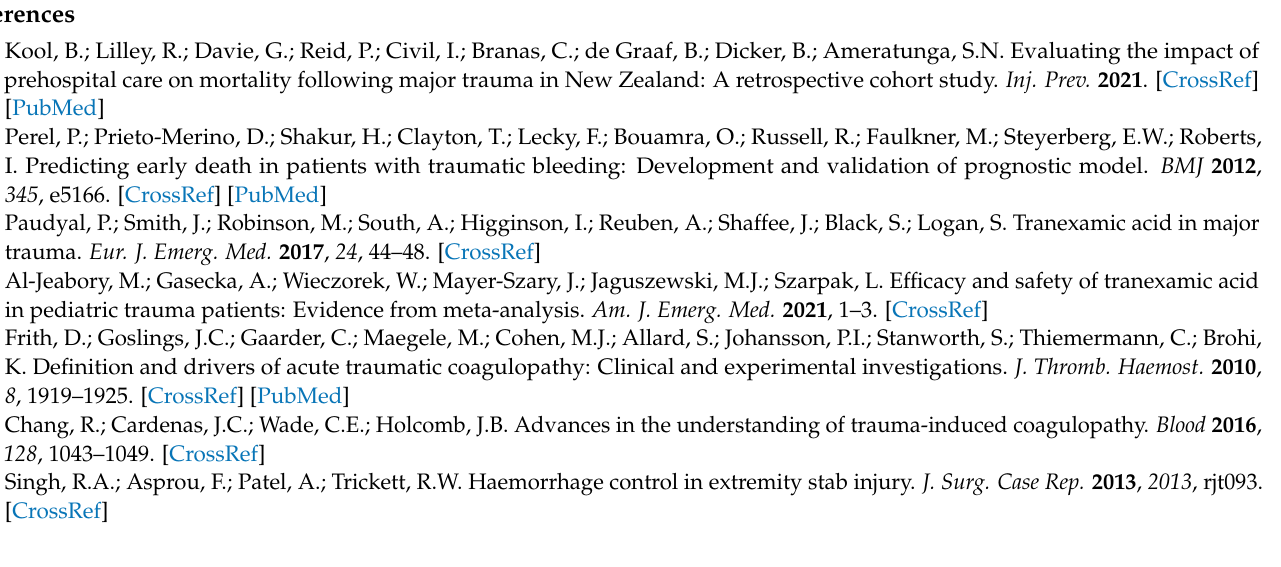
cause, Table S3: Adverse events, Table S4: Mechanism of injury, Table S5: Length of stay parameters, Figure S1. Forest plot of patients age in TXA vs. Control group; Figure S2. Forest plot of patient patients’ sex (male) in TXA vs. Control group; Figure S3. Forest plot of injury severity score at admission in TXA vs. Control group; Figure S4. A summary table of review authors’ judgements for each risk of bias item for each randomized study; Figure S5. A plot of the distribution of review authors’ judgements across randomized studies for each risk of bias item; Figure S6. A summary table of review authors’ judgements for each risk of bias item for each non-randomized study; Figure S7. A plot of the distribution of review authors’ judgements across non-randomized studies for each risk of bias